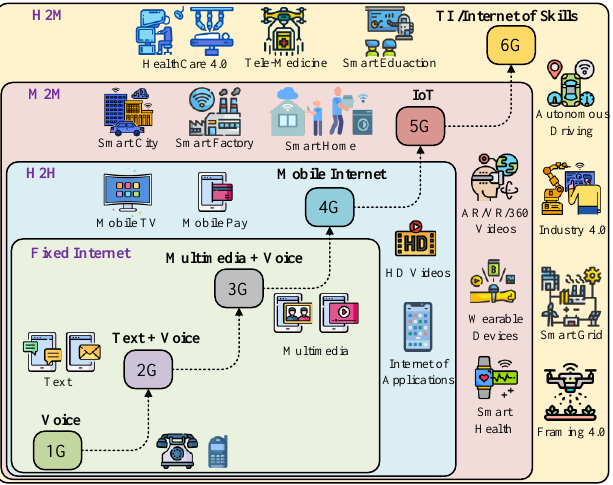
Figure 1. A taxonomy of the different emerging communication